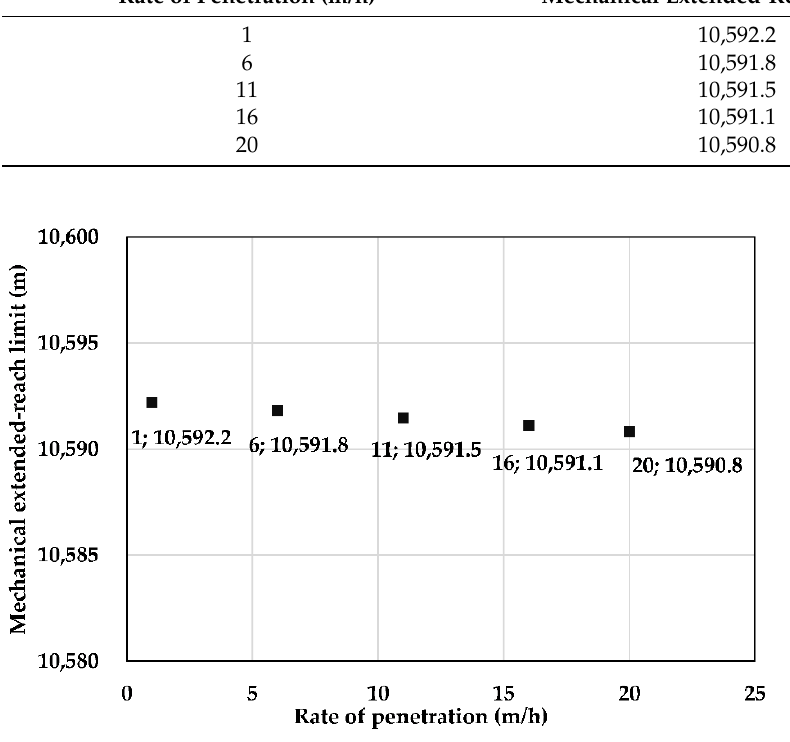
Figure 12. Effect of the rate of penetration on the mechanical extended-reach